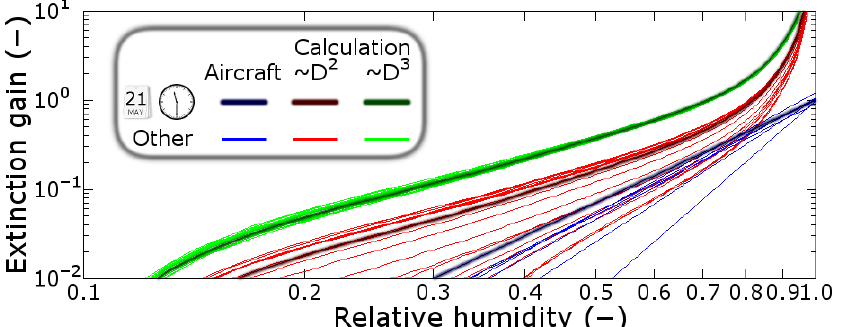
Fig. 9. Relative gain in scattering coefficient of aerosols as a function of relative humidity, without repartitioning of ammonium nitrate, with instant equilibrium for aerosol water. The calculations use observed (MARGA) surface concentrations of ammonium nitrate and ammonium sulphate and SMPS-observations at Cabauw of the aerosol size distribution, both for 21 May. One plume assumes condensation ( ∼ D 2 ) and the other assumes condensation ( ∼ D 3 ). Both plumes consist of twenty-four calculations, one per hour. The aircraft plots are power-law fits of measurements during several flights. Highlighted are the calculations for 11:30UTC and the function fit during the flight of 21 May, which was around the same time.